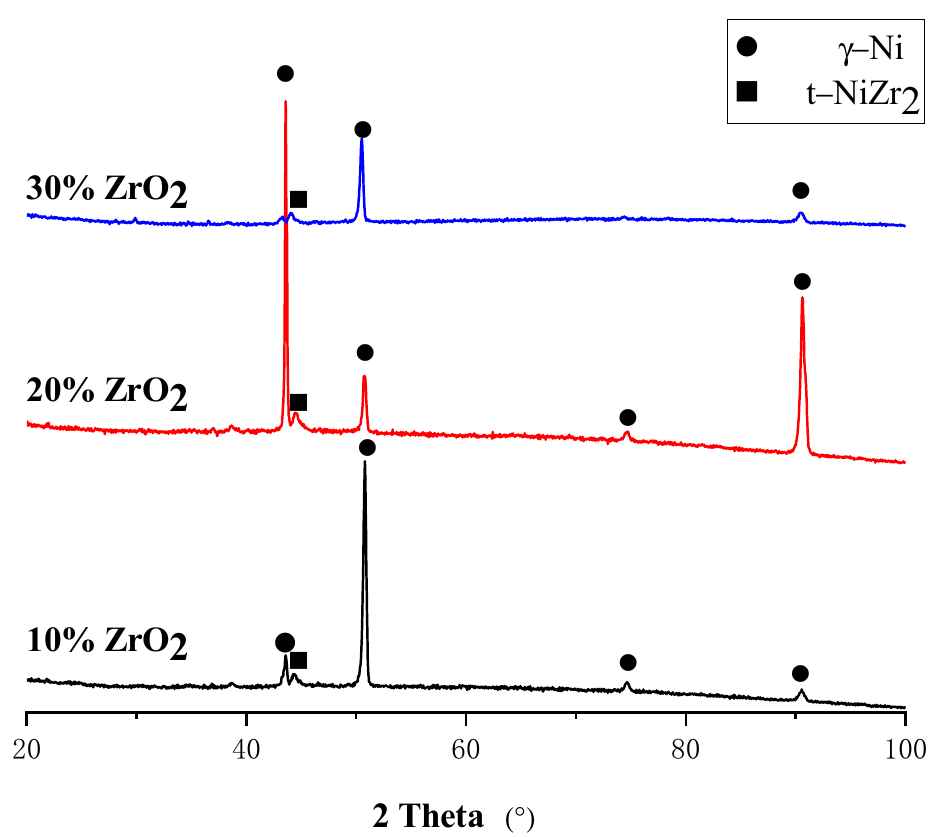
Figure 7. XRD patterns of different compositions of NiCrAlY-ZrO 2 composites.